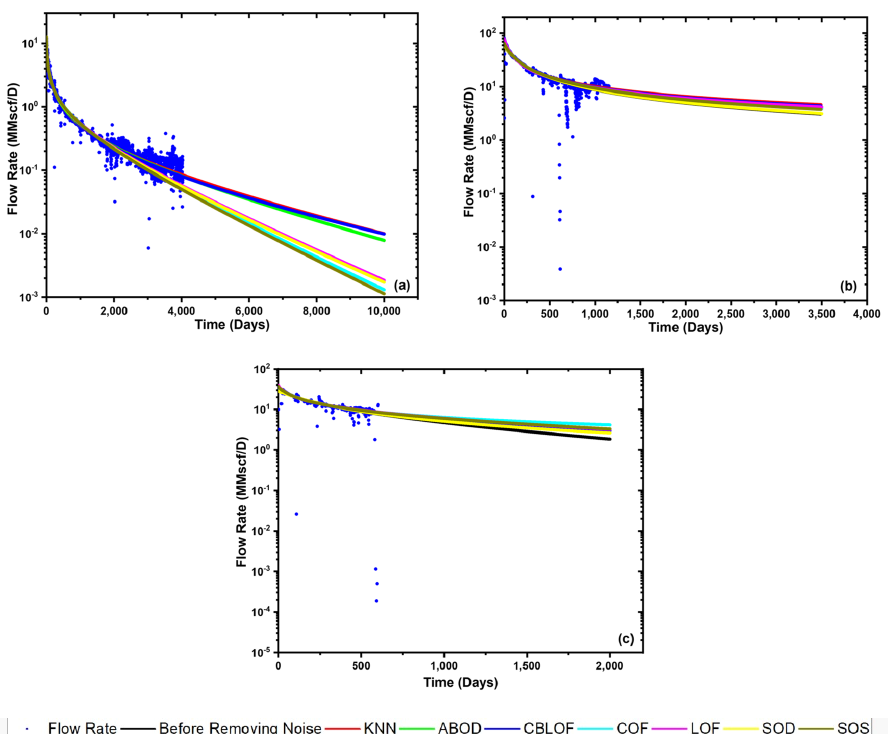
Figure 21. Applying the SEPD and PLE decline models before and after removing noise using the seven OD algorithms for; ( a )Well_12, ( b ) Well_29, and ( c ) Well_40.